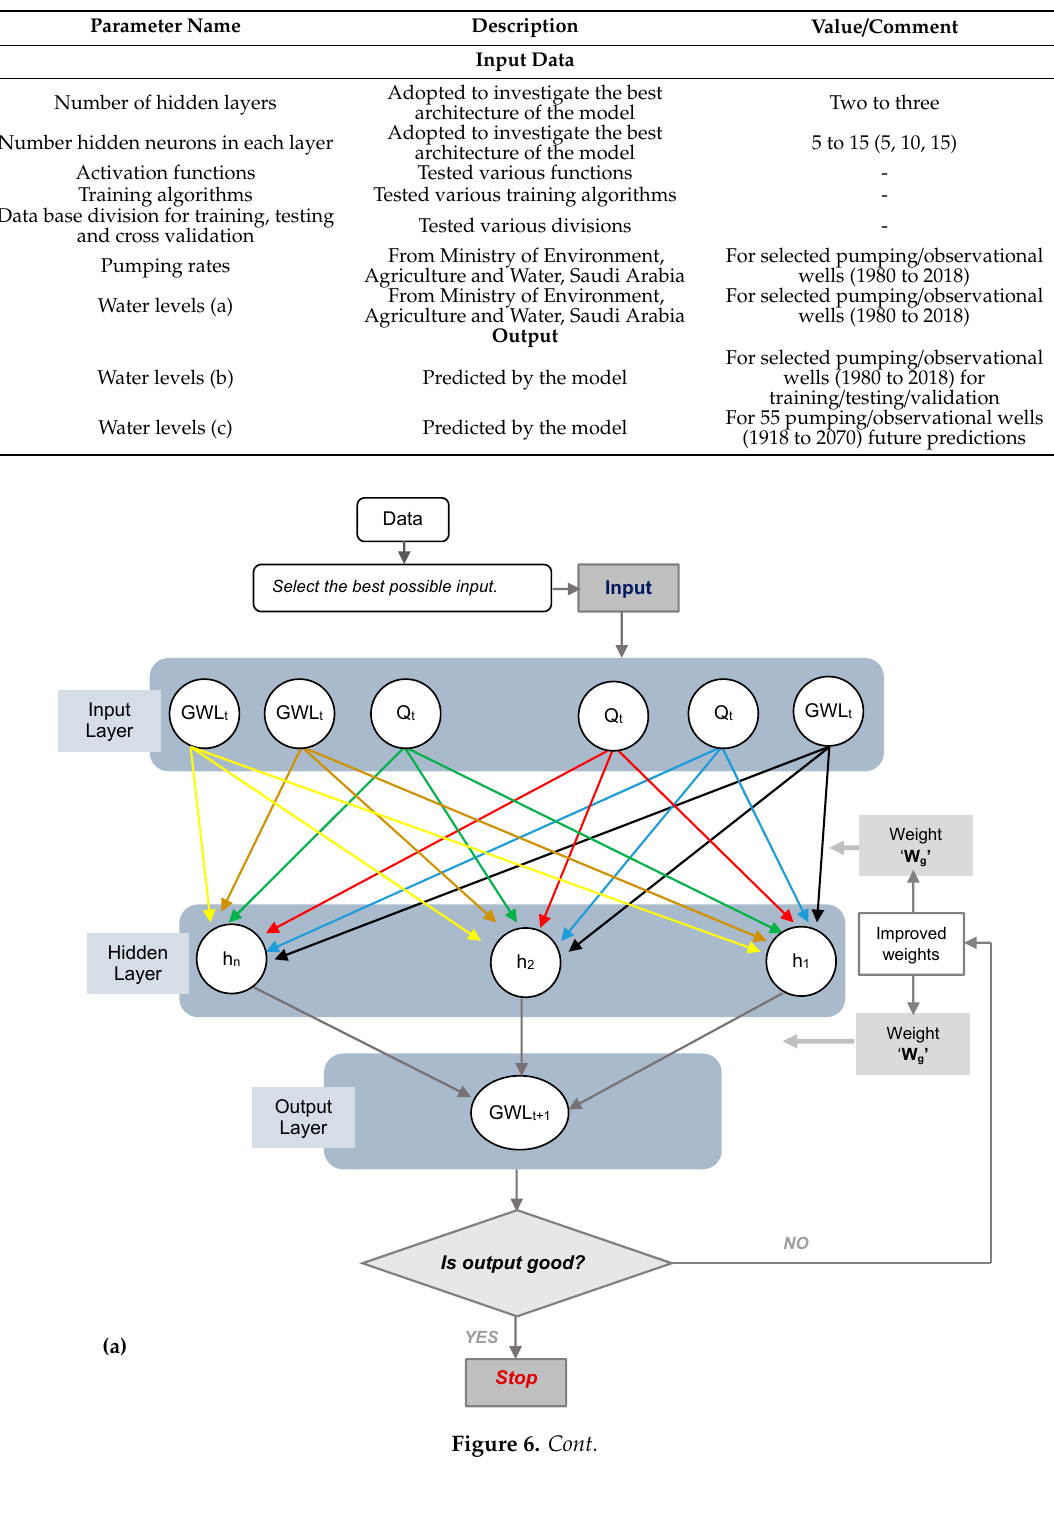
Figure 6. Modeling approach, ( a ) Flowchart representing the MLP (a feed-forward-ANN), ( b ) Five functional blocks in ANFIS.